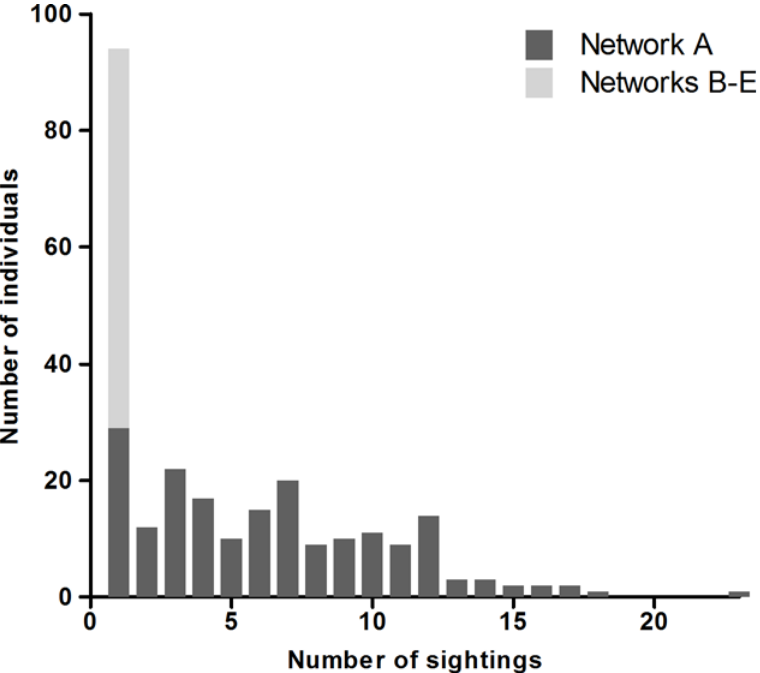
Fig 3. The number of sightings of individuals comprising network A and network